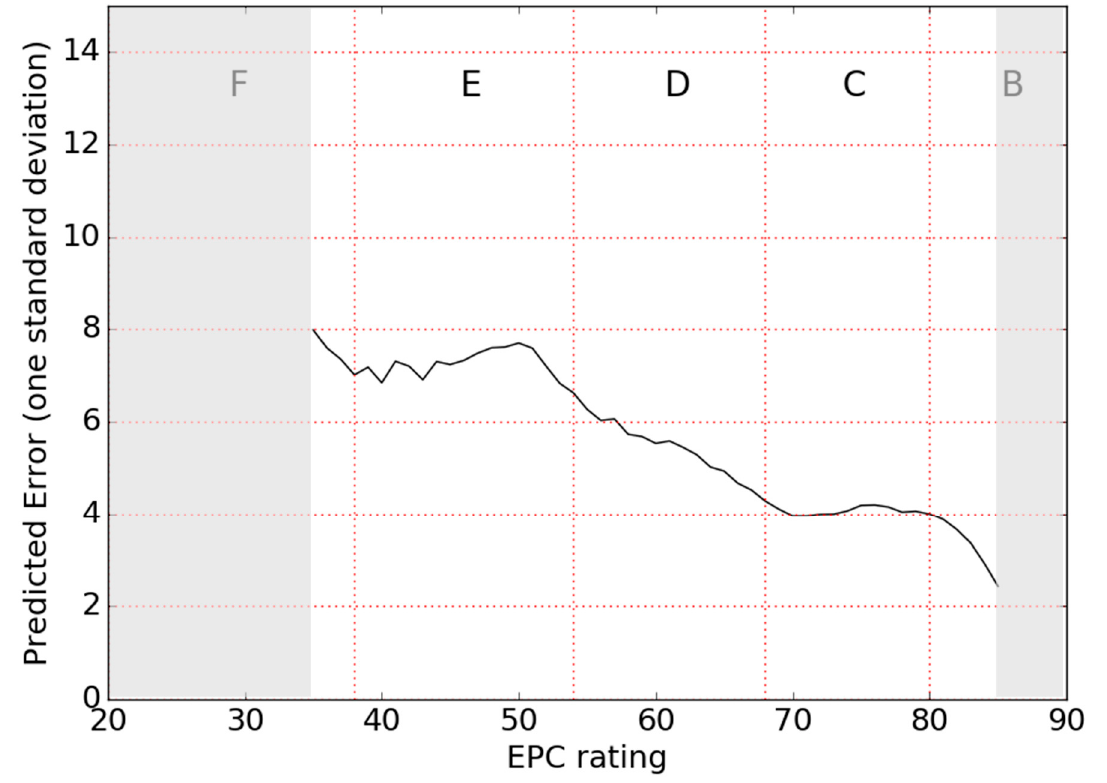
Figure 9. Predicted one standard deviation error for di ff erent EPC ratings. Grey areas are those in which assumptions are not valid, and therefore, the error is not estimated.